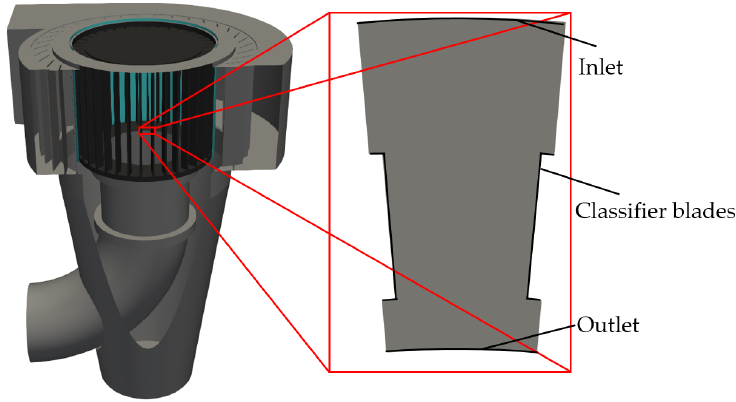
Figure 6. The simulated area for two-dimensional simulation.